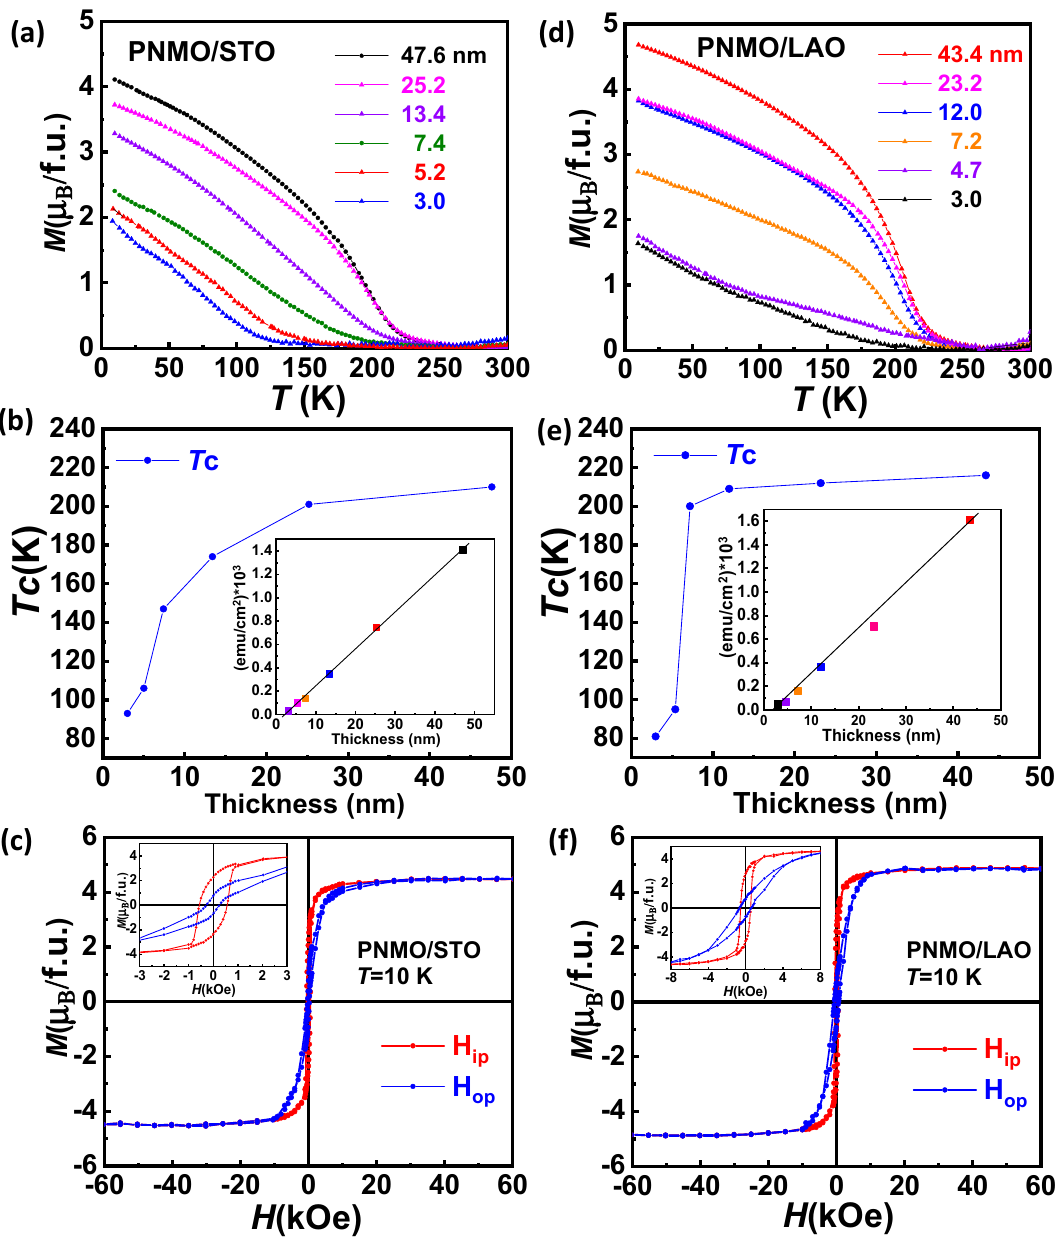
Figure 4. In-plane magnetization of ( a ) PNMO/STO and ( d ) PNMO/LAO thin films of different thicknesses as a function of temperature under an applied magnetic field of µ 0 H = 0.5 T. Curie temperatures T C of ( b ) PNMO/STO and ( e ) PNMO/LAO thin films as a function of thickness. Insets of ( b , e ) show the magnetization (emu/cm 2 )*10 3 at 10 K as a function of film thickness. M(H) hysteresis loops (measured at 10 K) with in-plane (red curve) and out-of-plane (blue curve) applied magnetic fields of ( c ) 47.6-nm-thick PNMO film deposited on STO substrate and ( f ) 43.4-nm-thick PNMO film deposited on LAO substrate. Insets ( c , f ) show the low field region in detail.